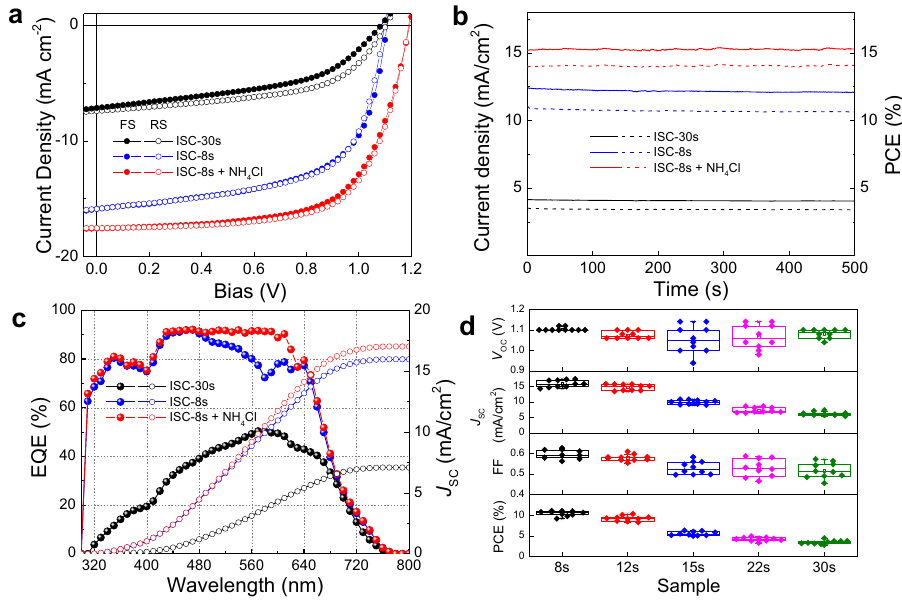
Fig. 6 Photovoltaic performance of devices fabricated by ISC versus spin-coating methods. a J − V characteristics, b stabilized outputs and c EQE pro fi les (solid circles) with integrated current density values (empty circles) of ISC-30s (i.e., SC method, black), ISC-8s (blue) and ISC-8s + NH 4 Cl (red) samples. d A statistic distribution of device parameters of various ISC times from 10 independent devices. The middle line, upper/lower box limits and upper/lower whiskers in the box plot indicate the median, 25th/75th quartiles, and maximum/minimum, are displayed in Fig. 6a − c, respectively. The obtained ef fi ciency is a respectable one among the analogous PEA 2 MA 3 Pb 4 I 13 (without − F substitution on PEA spacer) based devices as indicated by a